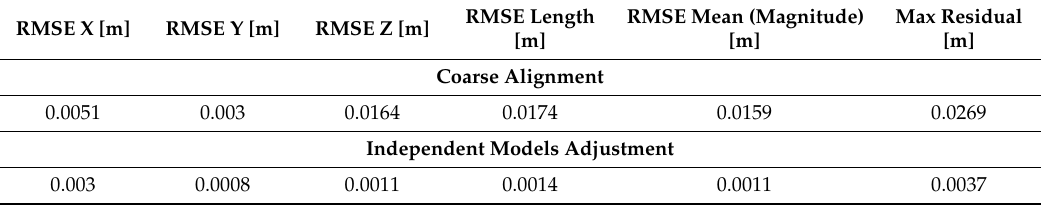
Table 4. Results of the transformations between underwater and the above the water coordinate systems. RMSE X [m]